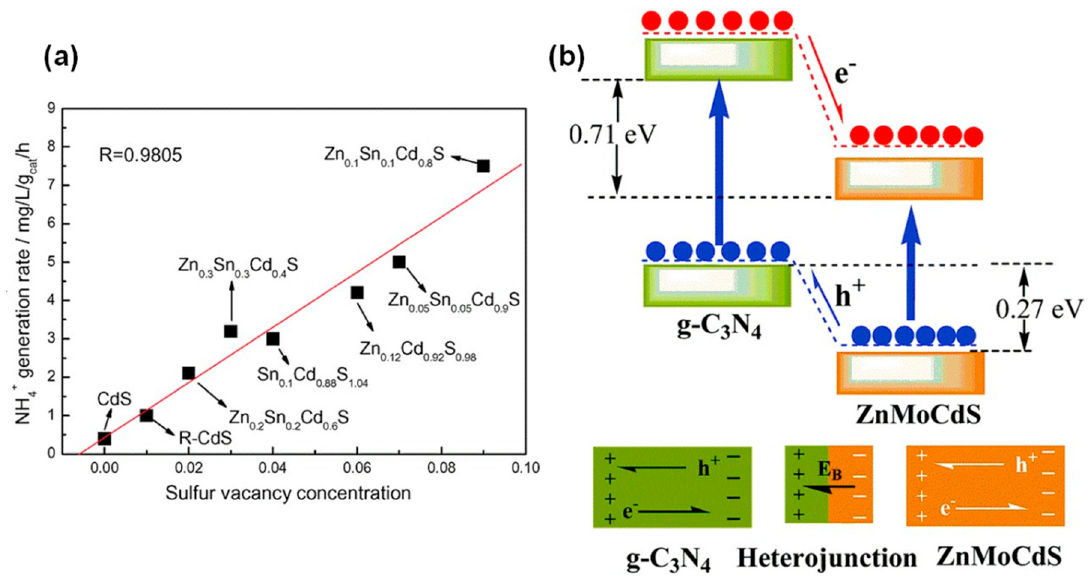
Figure 13. ( a ) Nitrogen photofixation performance of the as-prepared catalysts as a function of the sulfur vacancies concentration [70]; ( b ) The schematic of electron–hole separation and transport at the g-C 3 N 4 /ZnMoCdS heterojunction interface [71]. (Reproduced with permission from the respective publishers).